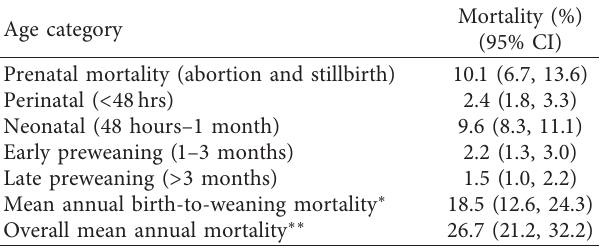
Table 1: Mean annual calf mortality and distribution by age category in urban and periurban dairy production system, 2014